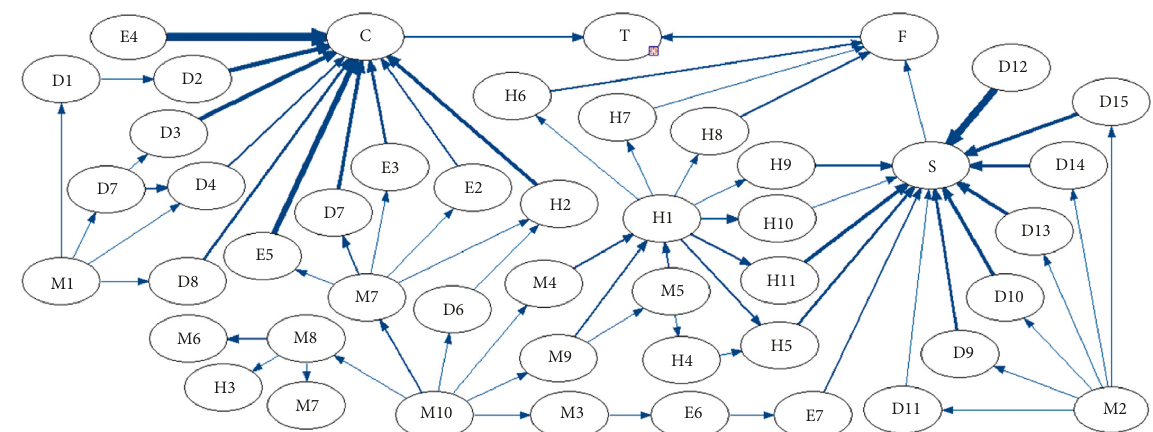
Figure 7: The maximum cause chain analysis of gas